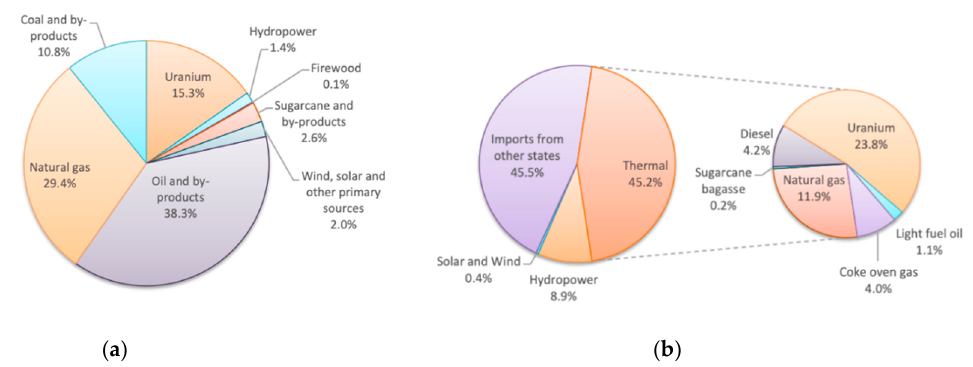
Figure 1. Internal energy supply ( a ) and electricity generation by source. ( b ) Rio de Janeiro state—2016. Source: [22].